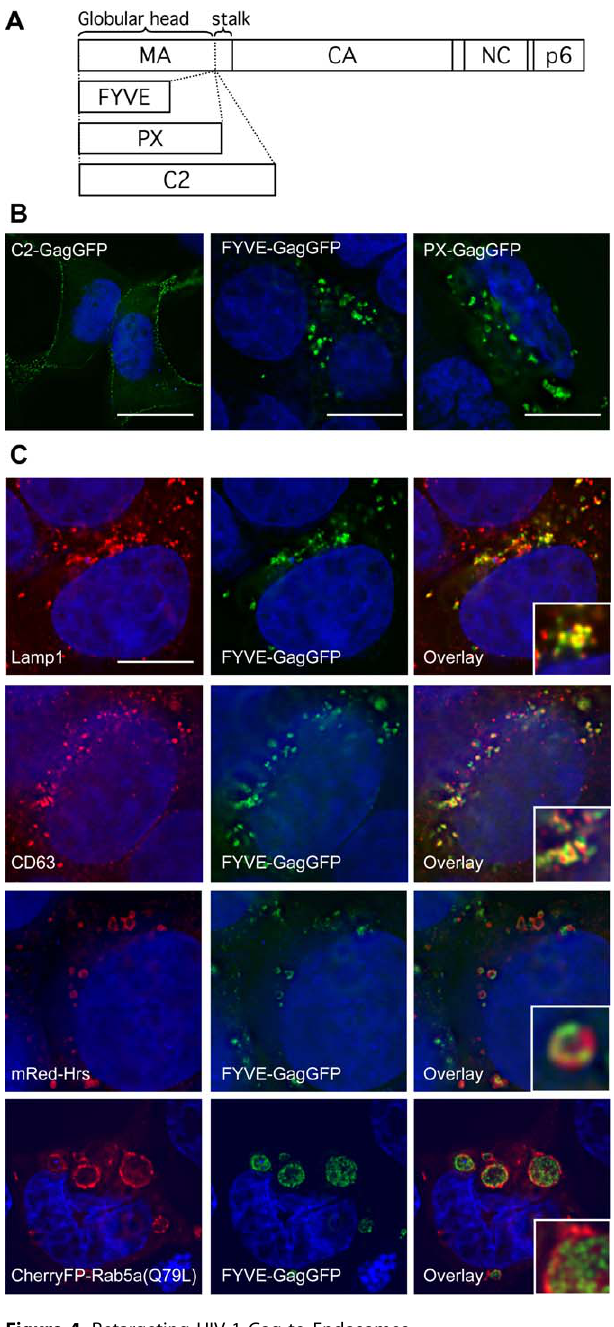
Figure 4. Retargeting HIV-1 Gag to Endosomes (A) Schematic representation of retargeted Gag proteins in which the globular head of matrix is replaced by specific membrane-binding domains. (B) Distribution of retargeted Gag proteins in 293T cells. Cells expressing FYVE-Gag-GFP, PX-Gag-GFP, or C2-Gag-GFP (green) were fixed at 24-h post-transfection. Scale bars indicate 8 l m (left panel) or 4 l m (center and right panels). (C) FYVE-Gag-GFP targets late endosomes. 293T cells expressing FYVE- Gag-GFP (green) were fixed at 24-h post-transfection and stained with anti–Lamp-1 or anti-CD63 antibodies (red). Alternatively, cells were co- transfected with mRed-Hrs or CherryFP-Rab5aQ79L (red). Insets show expanded views of individual FYVE-Gag-GFP accumulations. Scale bars indicate 4 l m. DOI: